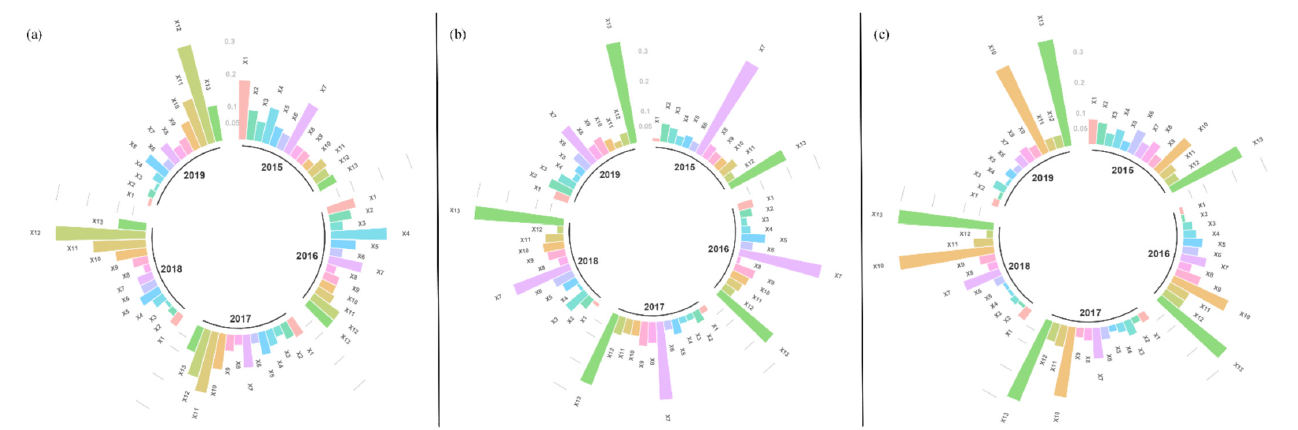
Figure 5. Spatial–temporal pattern of the factors affecting the long-term development of SAVs. ( a ) Fruit SAVs, ( b ) tea SAVs, and ( c ) livestock SAVs. The variables are × 1: elevation, × 2: slope, × 3: road network distance from SAVs to river, × 4: precipitation, × 5: soil quality, × 6: road network distance from SAVs to county, × 7: road network distance from SAVs to road network, × 8: road network distance from SAVs to the highway intersection, × 9: county urbanization population, × 10: county urbanization rate, × 11: disposable income of urban residents in the county, × 12: gross production value of the county, and × 13: number of agricultural enterprises in the county.